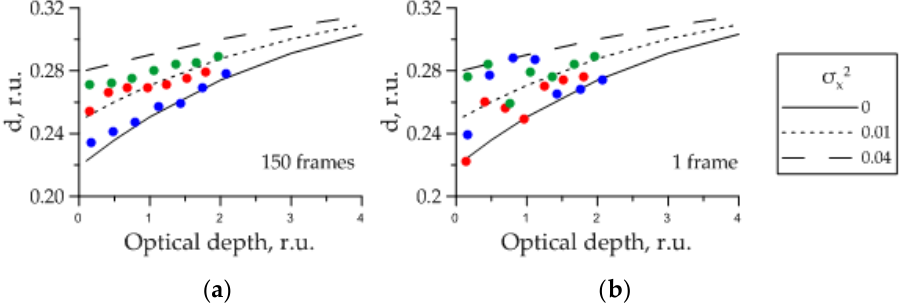
Figure 10. The comparison of theoretical values of parameter d with its empirical values obtained by ( a ) 150 frames and ( b ) 1 frame of the Snell ’ s window in each color filter: 420 nm (blue points), 530 nm (green points) and 650 nm (red points).